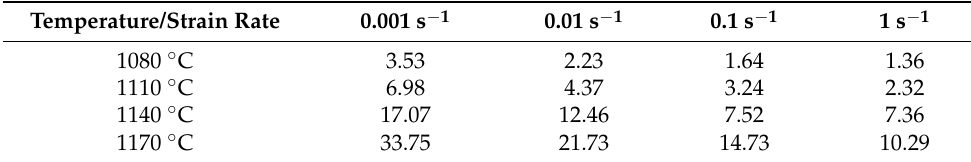
Figure 17. The effects of strain rate and strain on X drx at ( a ) 1080 °C; ( b ) 1110 °C; ( c ) 1120 °C; ( d ) 1140 °C; and ( e ) 1170 °C. ( f ) The comparisons between the calculated and experimental X drx . The DRX grain size ( d drx ) in the stable deformation stage is listed in Table 2. Obviously, the reduced strain rate or the raised temperature can increase d drx . Generally, d drx is connected with the compression parameters, which is evaluated through Sellars’s empirical equation [32,51]. Hence, according to experimental data, d drx is determined as: